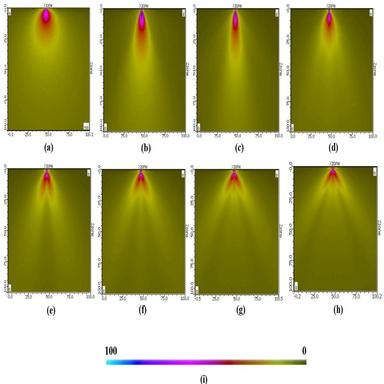
Sound beam computation results using active aperture comprising of (a) 1 el (b) 3 el (c) 4 el (d) 6 el (e) 8 el (f) 10 el, (g) 12 el and (h) 14 el. The colour scale corresponding to relative acoustic pressure is shown in (i). X-axis: Arbitrary location of active aperture on the surface of the sample (mm) Y-axis: Depth from the scanning surface (mm).